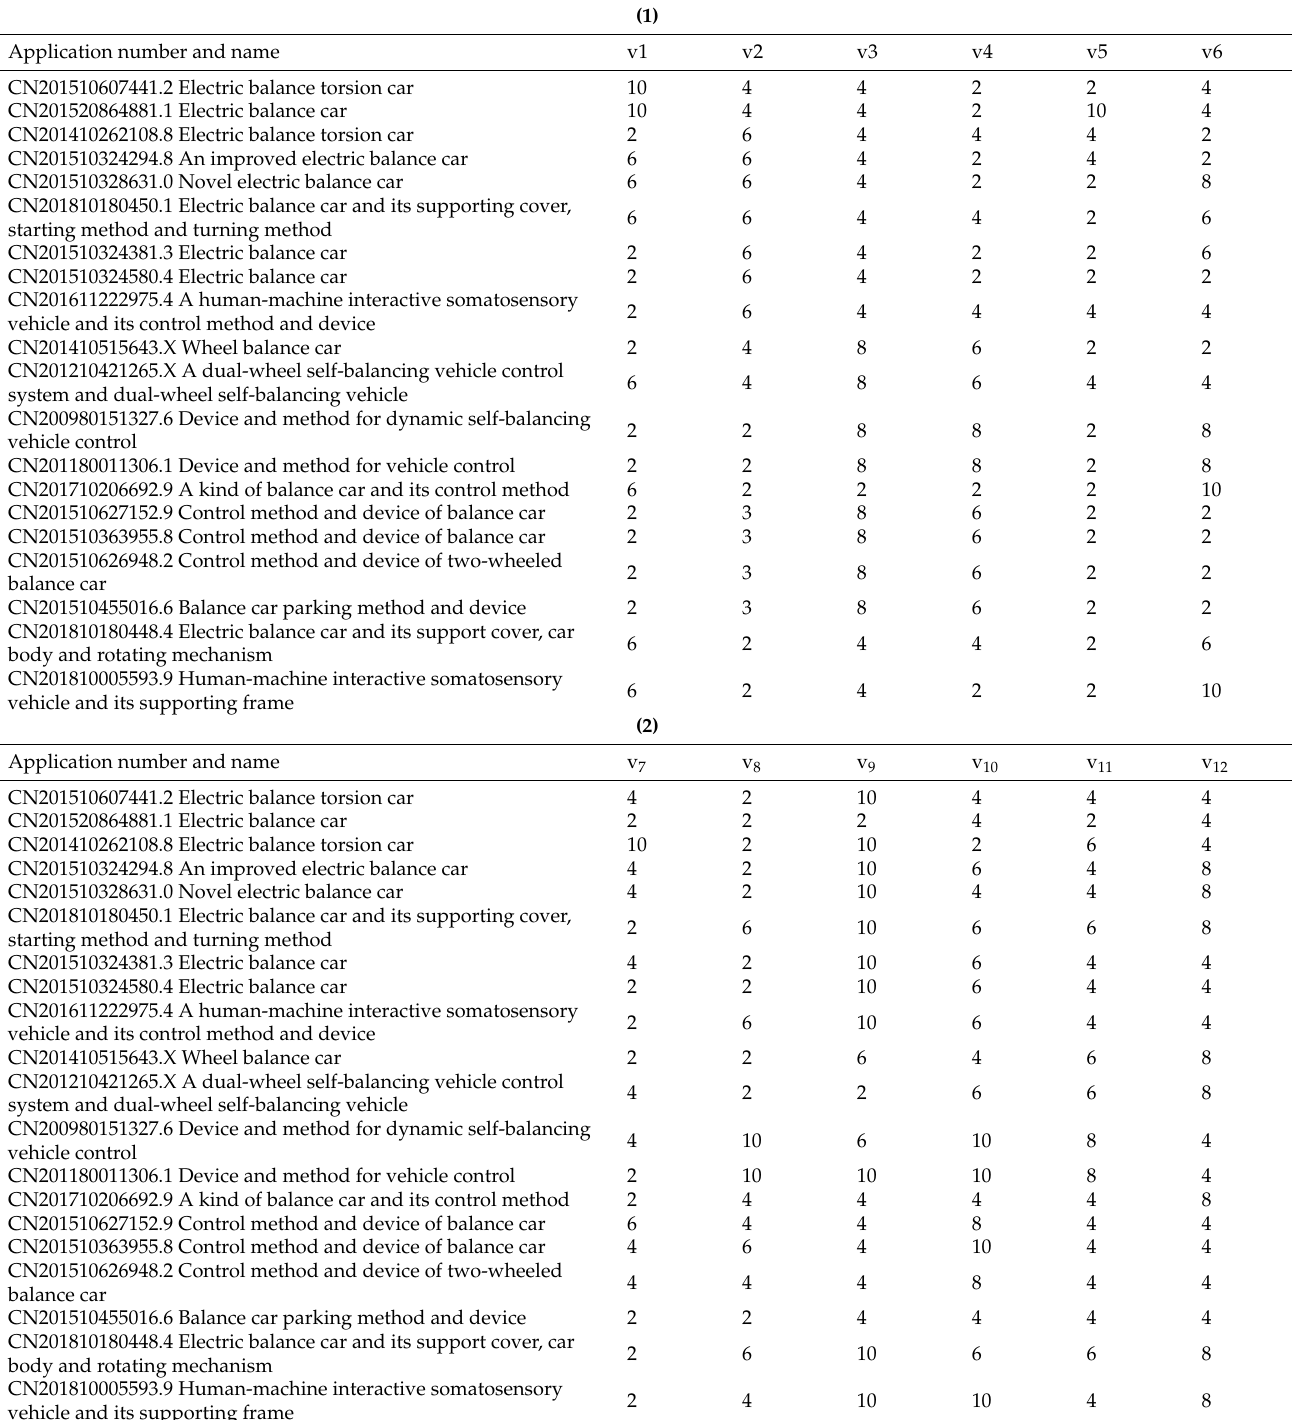
Table A7. ( 1 ) Original Score Table of Balance Vehicle Patents Data. ( 2 ) Original Score Table of Balance Vehicle Patent Data